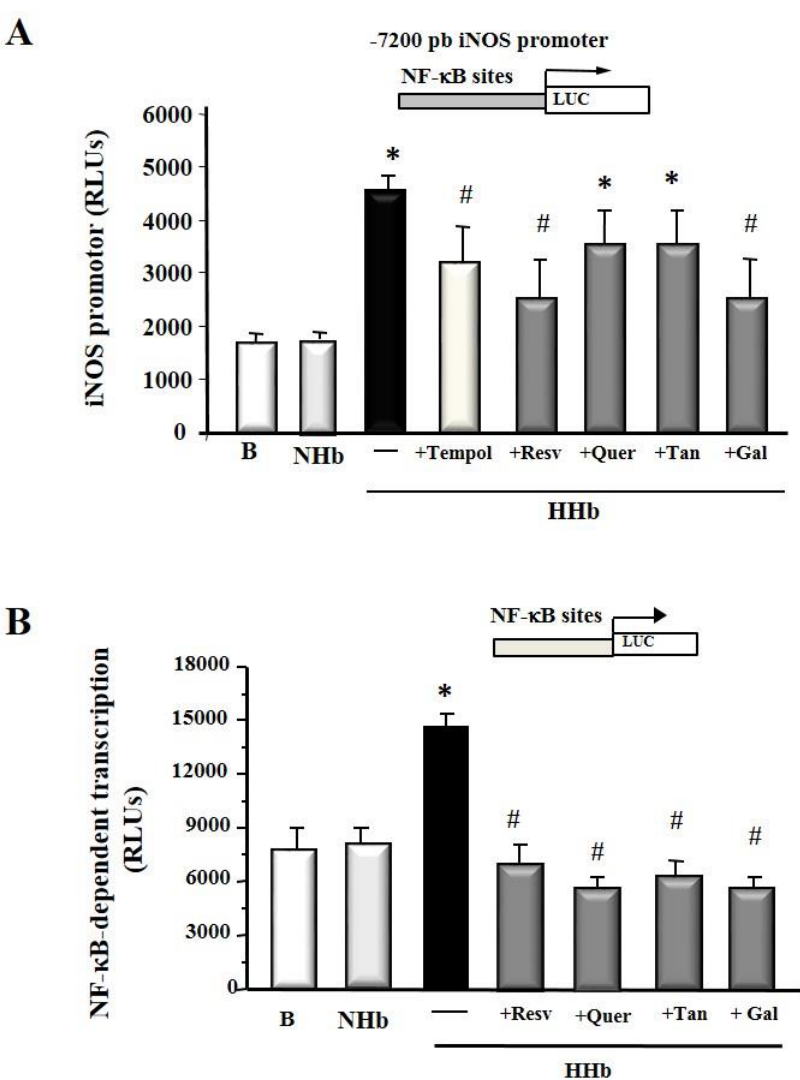
Figure 2. Polyphenols decrease proinflammatory gene expression induced by Amadori products. ( A ) The Human inducible Nitric Oxide synthetase (iNOS) promoter was studied using luciferase-based reporter plasmids transiently transfected in HPMCs; ( B ) nuclear factor-kappaB (NF-kB)-dependent transcriptional activation was assessed in cells transiently transfected with p5NF-kB-Luc plasmid. HPMCs were treated HHb and NHb (both at 10 nM); polyphenols: resveratrol (Resv, 12.5 µ M), tannic acid (Tan, 10 µ M), quercetin (Quer, 10 µ M), gallic acid (Gal, 10 µ M); or Tempol (Temp, 100 µ M), a ROS scavenger. For each experiment, 10 independent cultures of HPMCs were used, corresponding to 10 donors. Data represent the mean ± SD of at least seven independent experiments (for each culture of HPMCs corresponding to each of the 10 donors) expressed as relative light units (RLUs). * p ≤ 0.05 vs. basal. # p ≤ 0.05 vs. HHb.